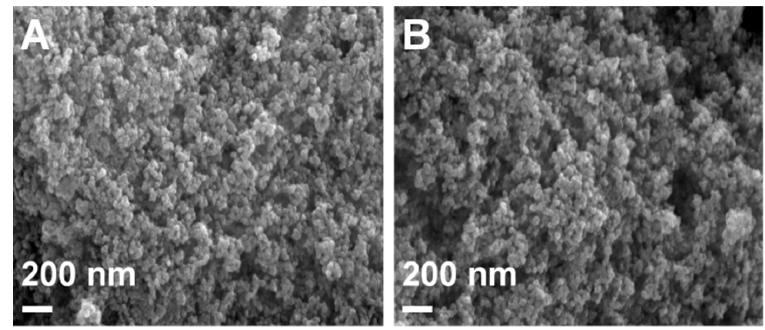
Figure 4. SEM images of ( A ) product TiO 2 compared with ( B ) commercial TiO 2 .